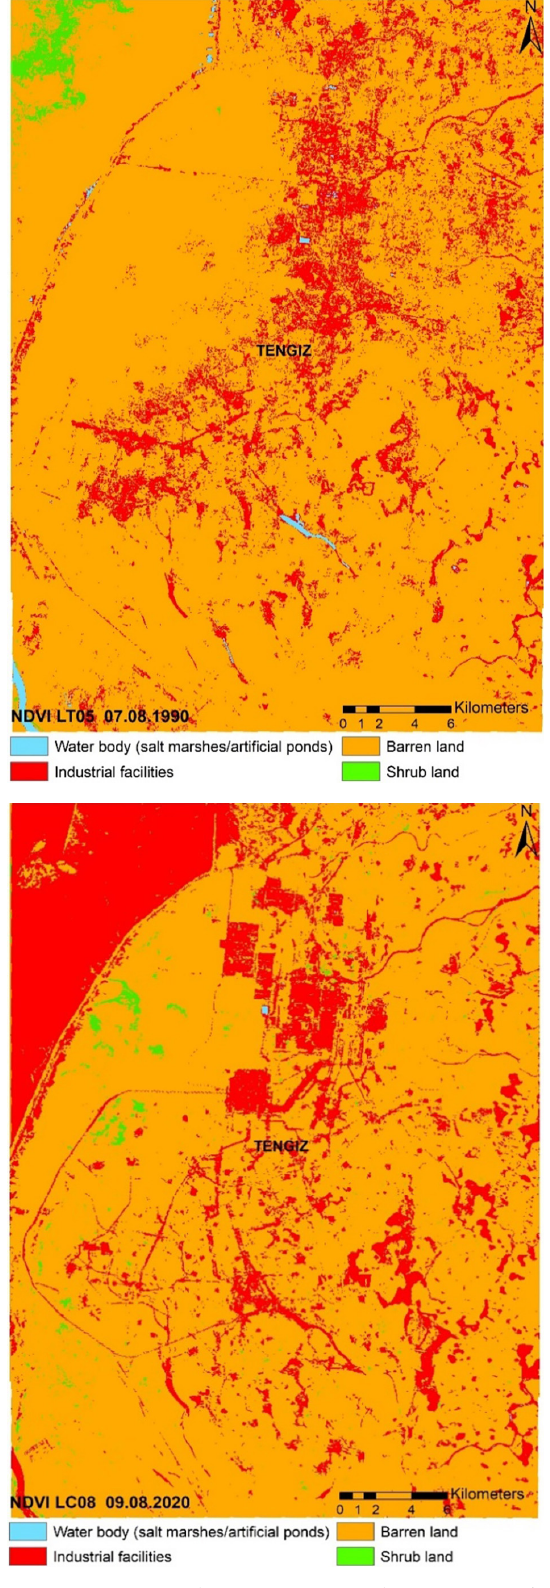
Fig. 5. Landscape cover on the territory of the Tengiz oil field based on the results of NDVI. NDVI – normalised difference vegetation index; S2A – Sentinel-2A. Source: own